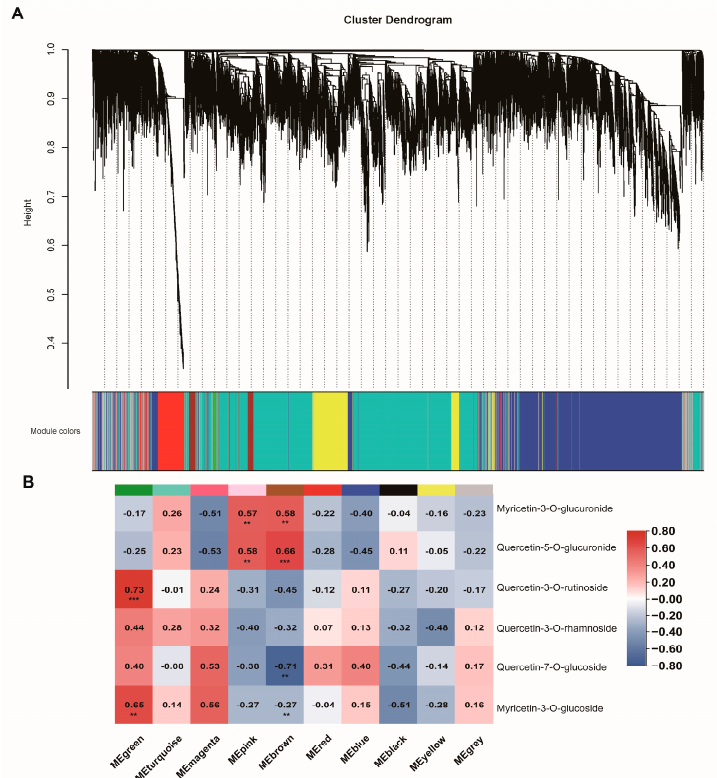
Figure 6. ( A ) The dendrogram shows modules identified by WGCNA and clustering dendrogram of expressed genes; and ( B ) heatmap of correlation coefficients for flavonoids content and module eigengenes. The blocks in red and blue represent positive and negative correlations, respectively. ** and *** indicate significant differences at p < 0.05 and p < 0.01, respectively.